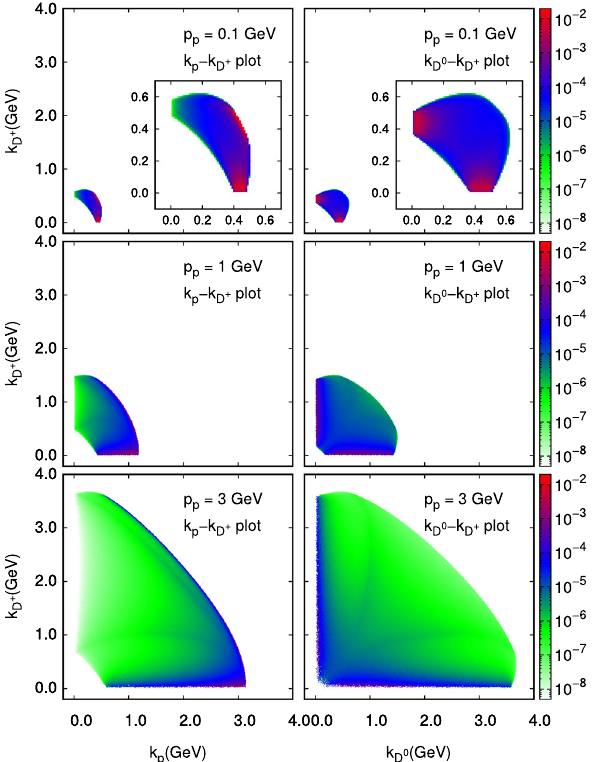
Fig. 3 Themomentumdistributionsoffinalparticlesforthe p + T + cc → p + D + + D 0 reaction with cutoff (cid:21) = 1 GeV. For each example choice of p p , the figures represent the k p − k D + (left) and k D 0 − k D + (right) planes, showing the momentum k i = | k i | of the final meson i . The col- orbox means the ratio of event number in a bin of 0.01 GeV × 0.01 GeV to the total number of events. The results are obtained with 10 8 simu-